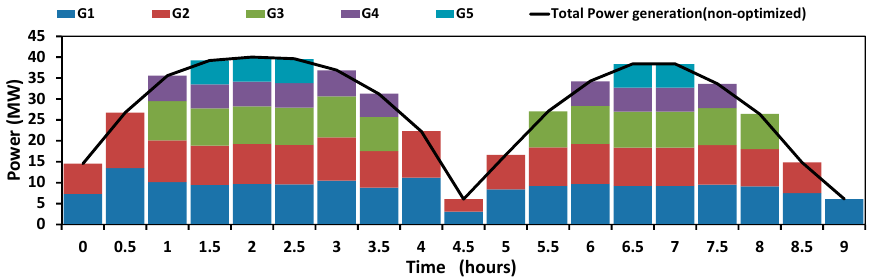
Figure 3. Performance of the best particle vs. Particle Swarm Optimization (PSO) epochs.